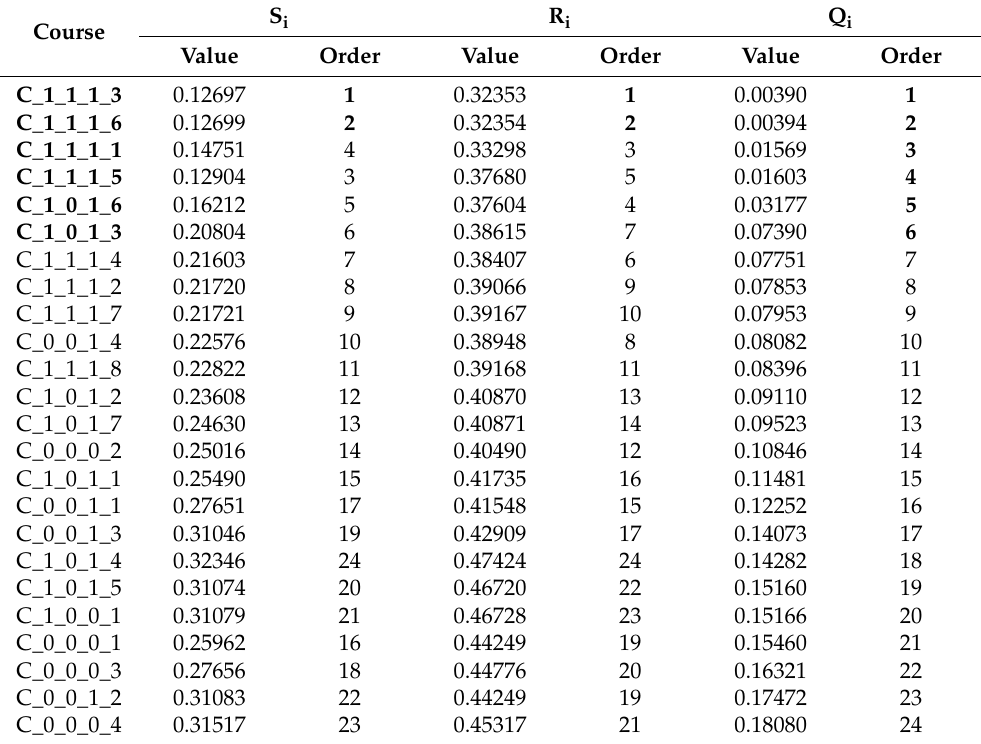
Table 11. Teacher evaluation: Fuzzy VIKOR results and ranking courses by S, R and Q ( υ =